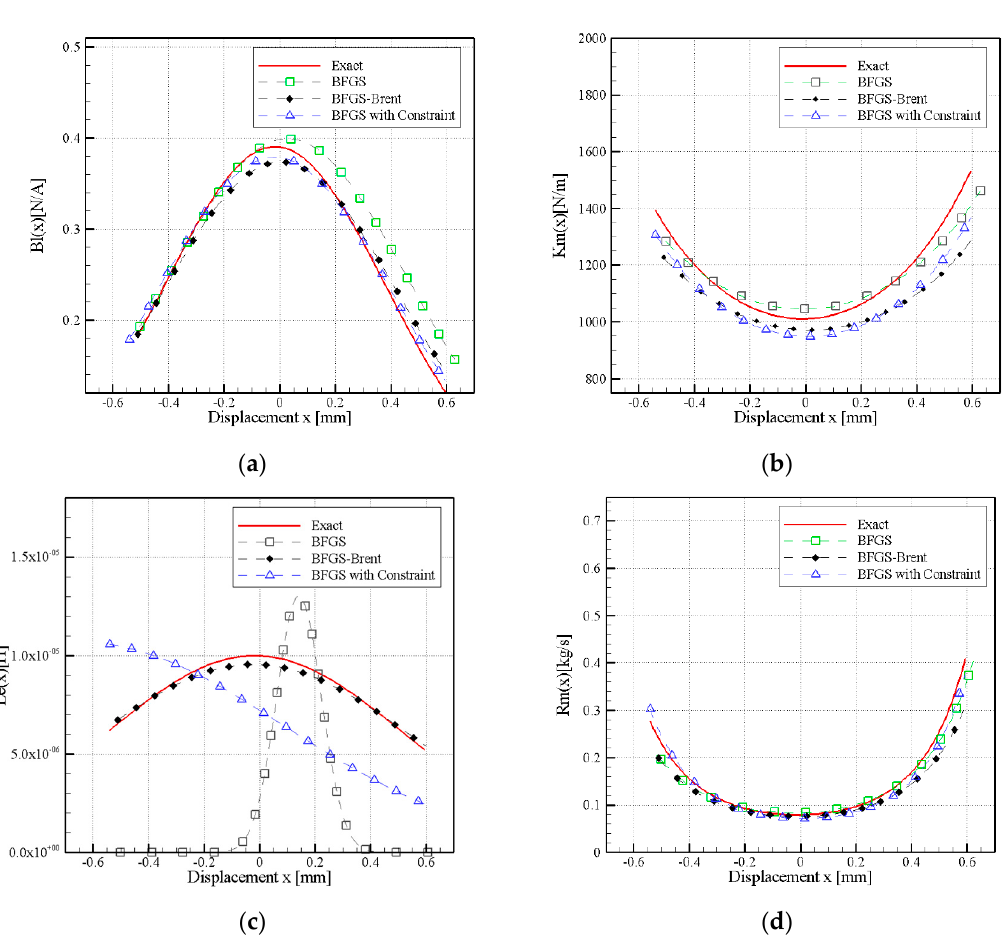
σ σ on nonlinear parameters, ( a ) Bl ( x ), ( b ) K m ( x ), ( c ) L e ( x ), on nonlinear parameters, ( a ) Bl ( x ), ( b ) K m ( x ), ( c ) L e ( x ),